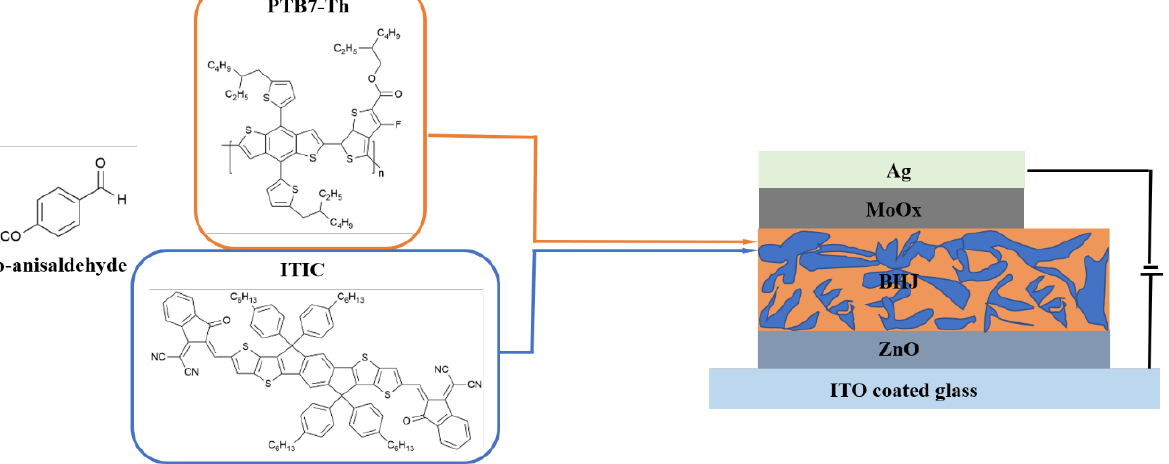
Figure 5. The device structure and the molecular structures of PTB7-Th, ITIC and p-anisaldehyde (AA).